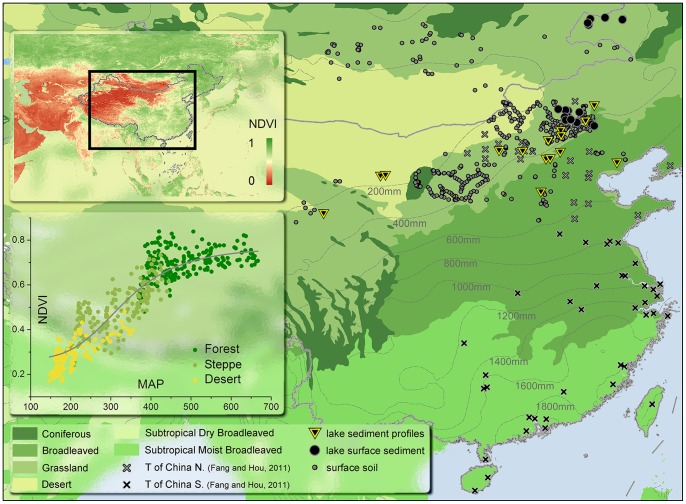
Sample locations and modern NDVI distribution.Modern NDVI data were acquired by averaging data for August from 1982–2006 of the GIMMS dataset. NDVI in South China is homogeneous at a high level, while that of North China varies widely with precipitation. Samples of NDVI-MAP relationships were randomly chosen from grid points with natural vegetation in our study area (North China) and fitted by a logistic curve. Sites with surface soil pollen, lake surface pollen and sediment profiles are distributed around the 400 mm isohyet; some sites with surface soil pollen samples are located in Mongolia, but in the same biome and precipitation regime. T of China N. and T of China S. indicate the paleotemperature records used in the temperature reconstruction of North China and South China [70], respectively.